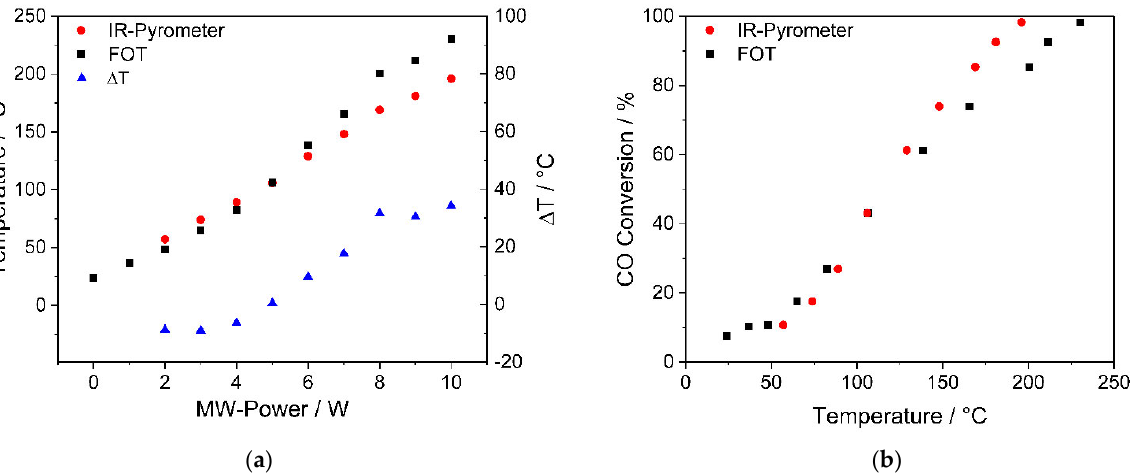
Figure 3. ( a ) Measured temperatures of an LSC ‐ 82 catalyst powder for both the FOT contact thermal sensor and IR ‐ pyrometer as a function of applied MW ‐ power after calibration at 110 °C (left axis), difference between the two thermal sensing methods for the same measurement data (right axis).